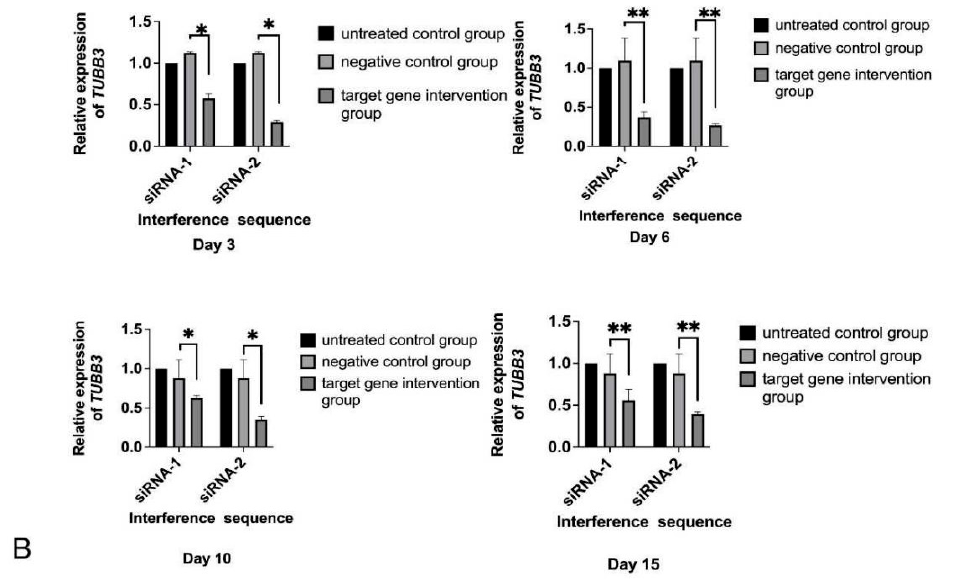
Figure 1. siRNA targeting EmTUBB3. ( A ) Sequence of EmTUBB3 and target sites of siRNA-1 and siRNA-2. ( B ) Relative expression of TUBB3 in E. multilocularis PSCs treated with siRNA-1 and siRNA-2 at different time points. * p -value < 0.05, ** p -value < 0.01.